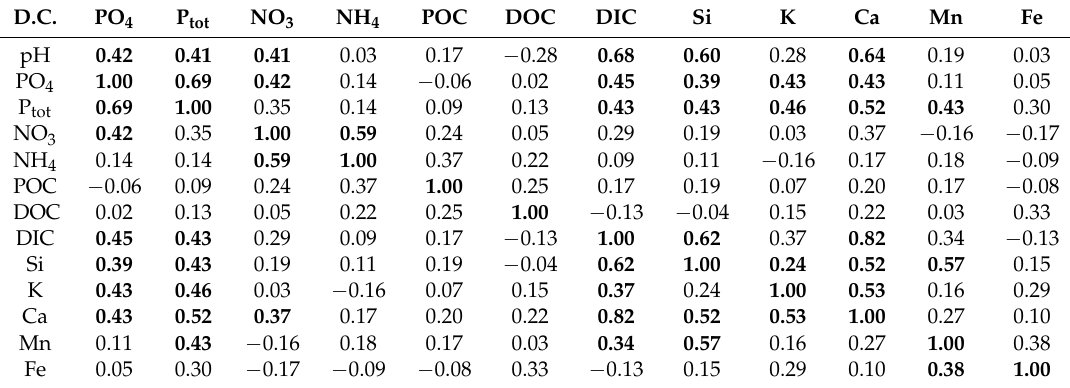
Table 1. Correlation matrix of dissolved components (D.C.) and nutrient concentrations in all rivers sampled during June and August. Marked (bold) Pearson correlations R > 0.40 are significant at p < 0.05 (N =